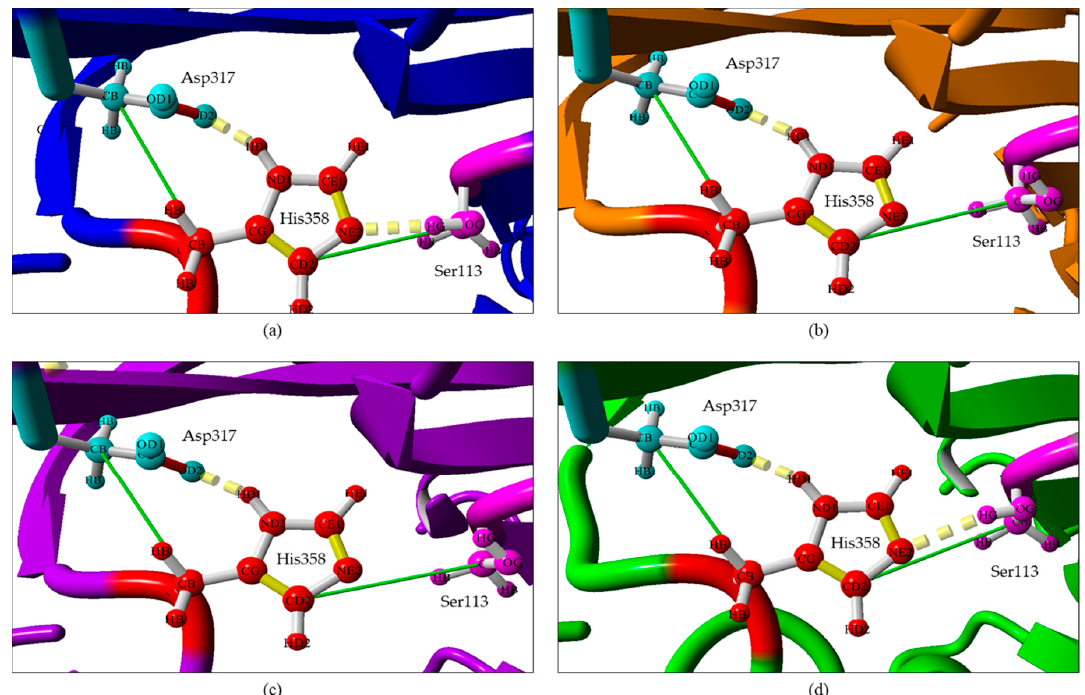
Figure 2. The hydrogen bonds (yellow dashes) and hydrophobic interactions (green line) in the catalytic triad of wt-L2 and mutant lipases. ( a ) wt-L2, ( b ) A8V, ( c ) A8P and ( d ) A8E.